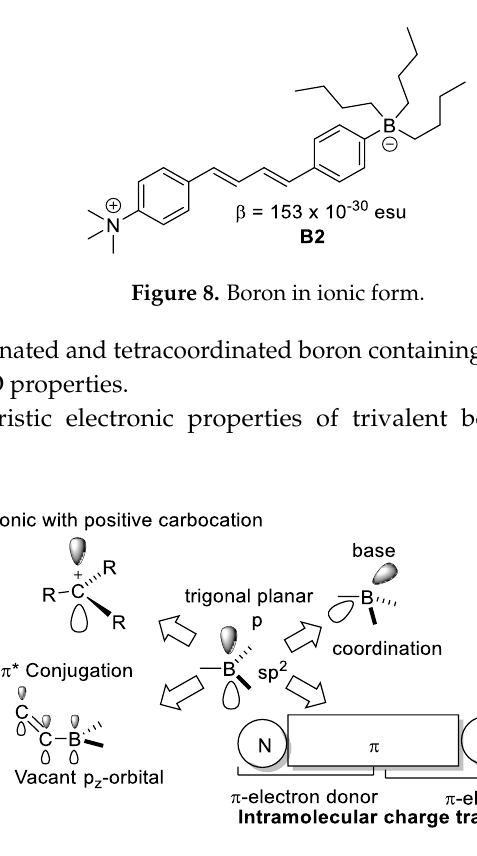
Figure 9. Main features of three-coordinated boron compounds.